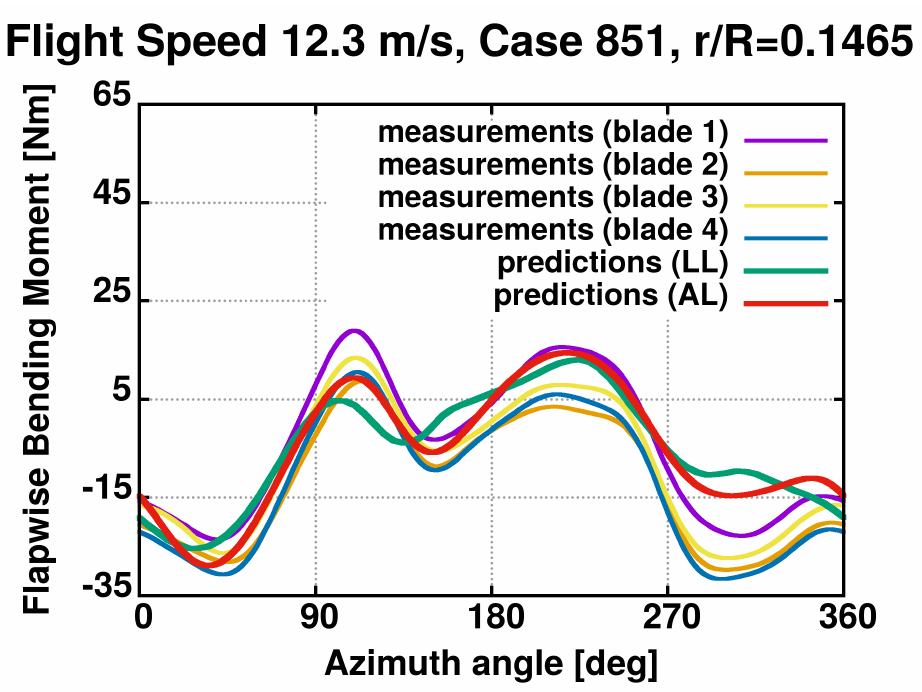
Figure 38. Forward flight at 12.3 m/s, case 851. Flapwise moment at r / R = 0.1465.